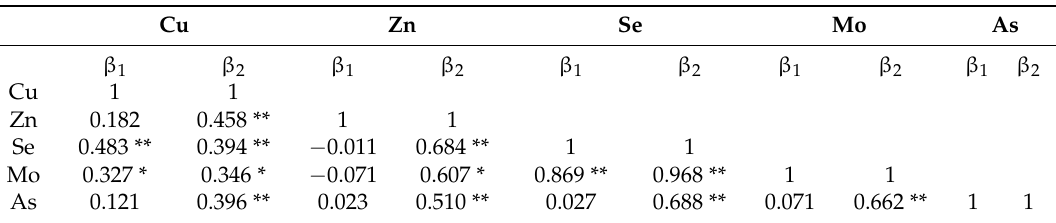
Table 3. Spearman correlation coefficients between different trace element concentrations excreted in dialysate ( β 1 ) and in urine ( β 2 ).